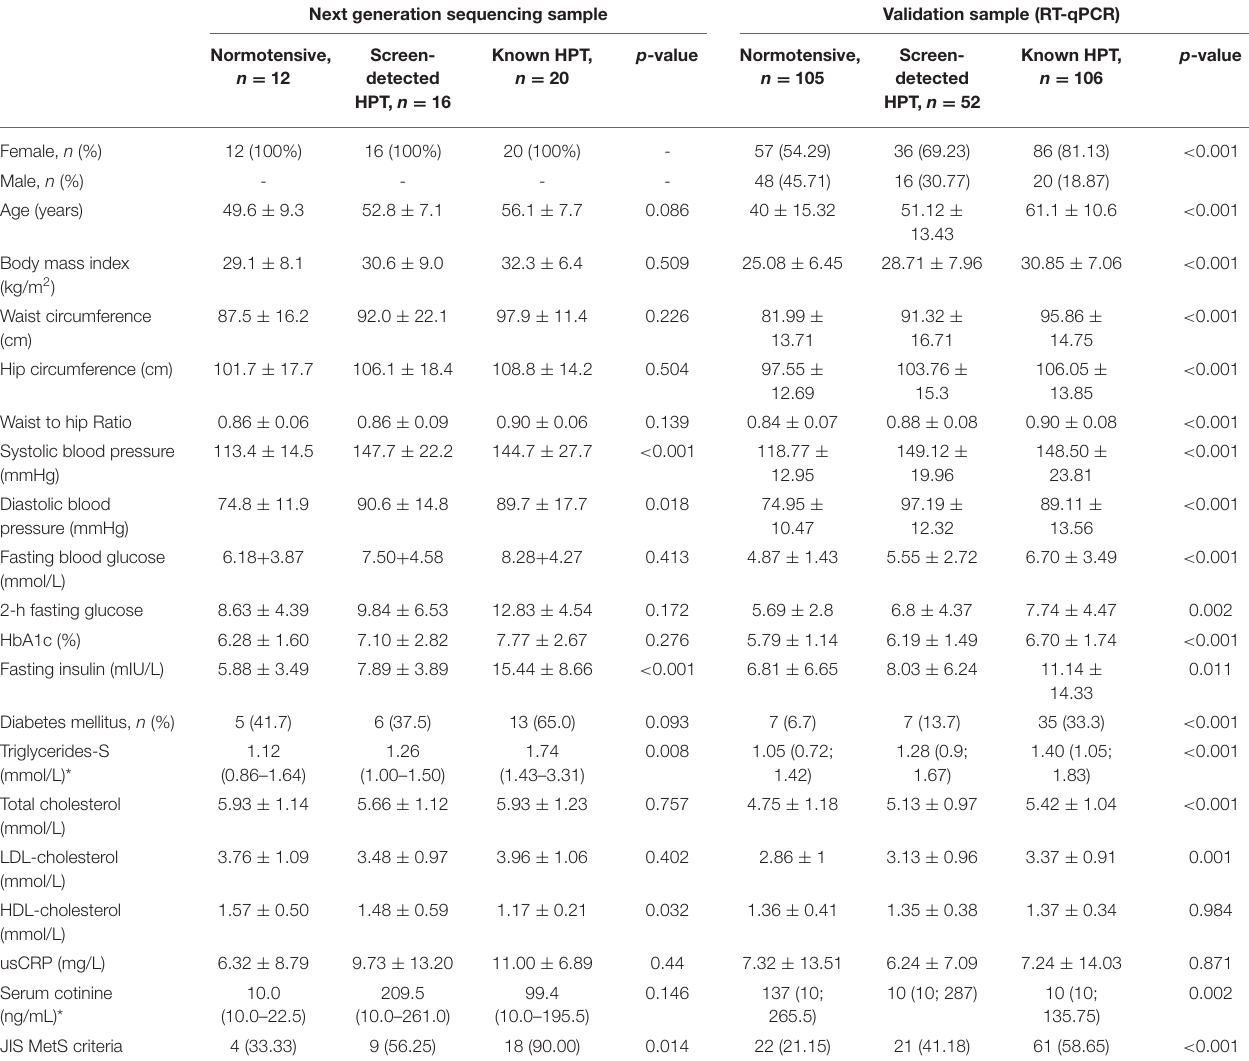
Values presented as mean ± SD unless marked with an asterisk * , in which case the median and (25th-75th percentiles) are reported. The Kruskal-Wallis-test and analysis of variance (ANOVA) were used to compare the median and mean baseline characteristics, respectively, across blood pressure groups. SD, standard deviation; usCRP, ultrasensitive CRP; MetS, Metabolic Syndrome.